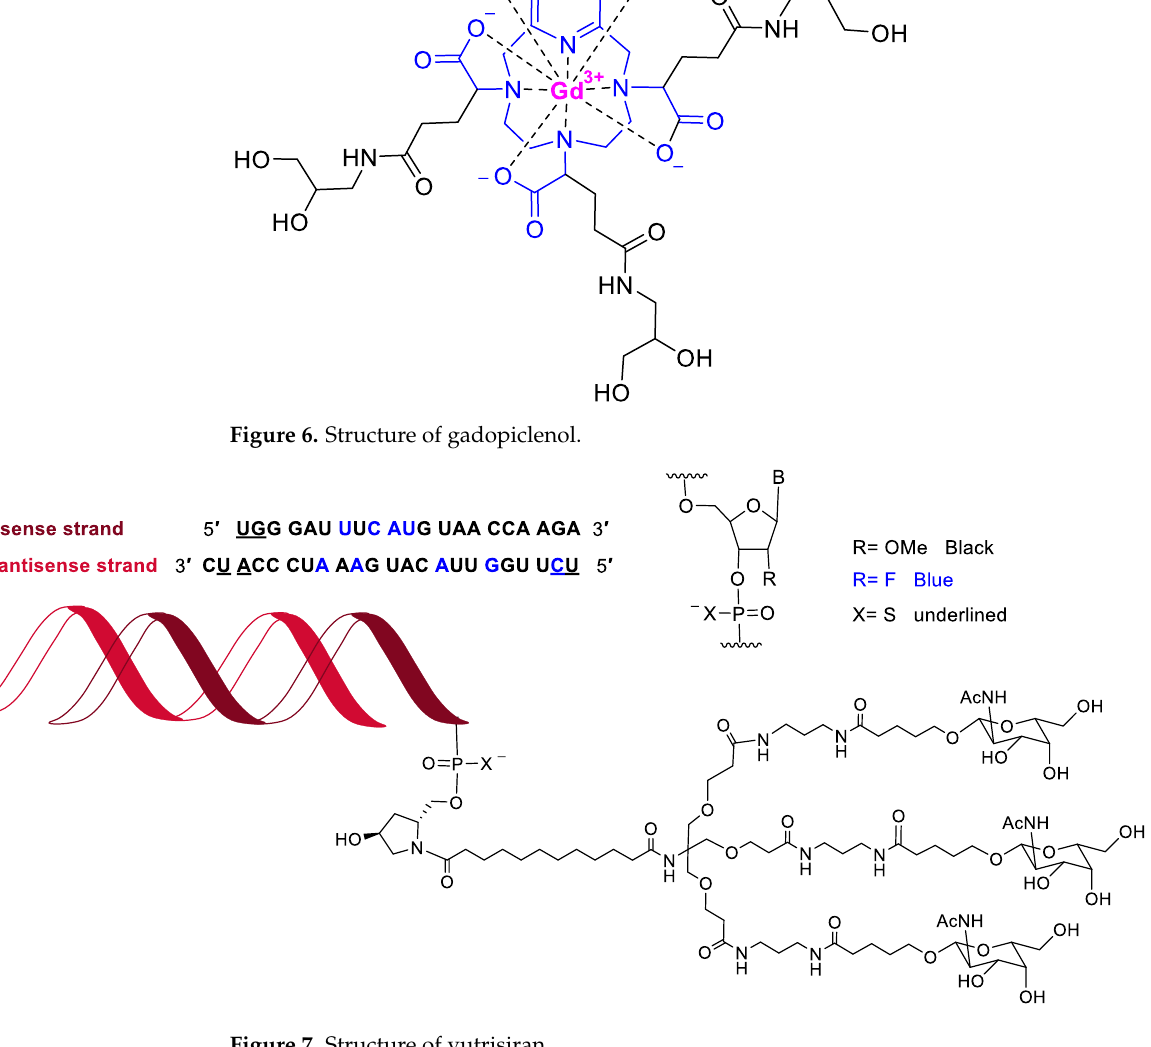
Figure 7. Structure of vutrisiran.